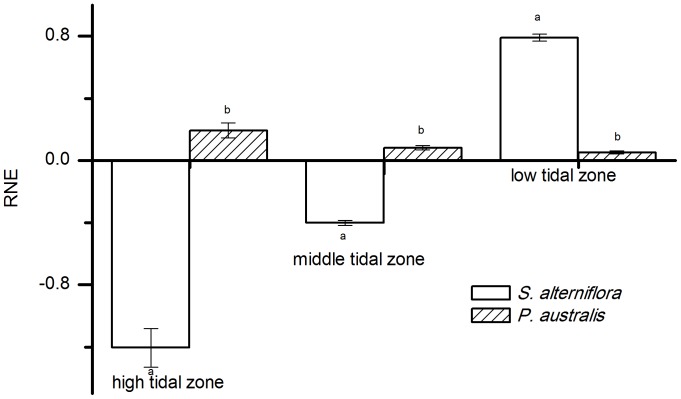
The relative neighbor effect (RNE) of P. australis and S. alterniflora in different tidal zones.The performance of target plants was measured by the relative growth rate per day (RGR). Different letters indicate significant differences.